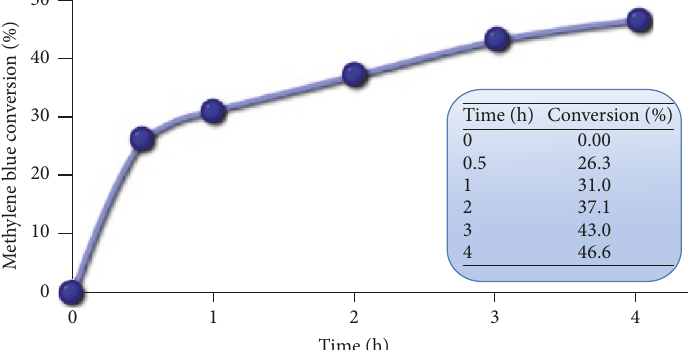
Figure 8: Temporal evolution of MB removal during photocatalytic experiments under UV light irradiation using 3DAS fabricated with the first route (Section